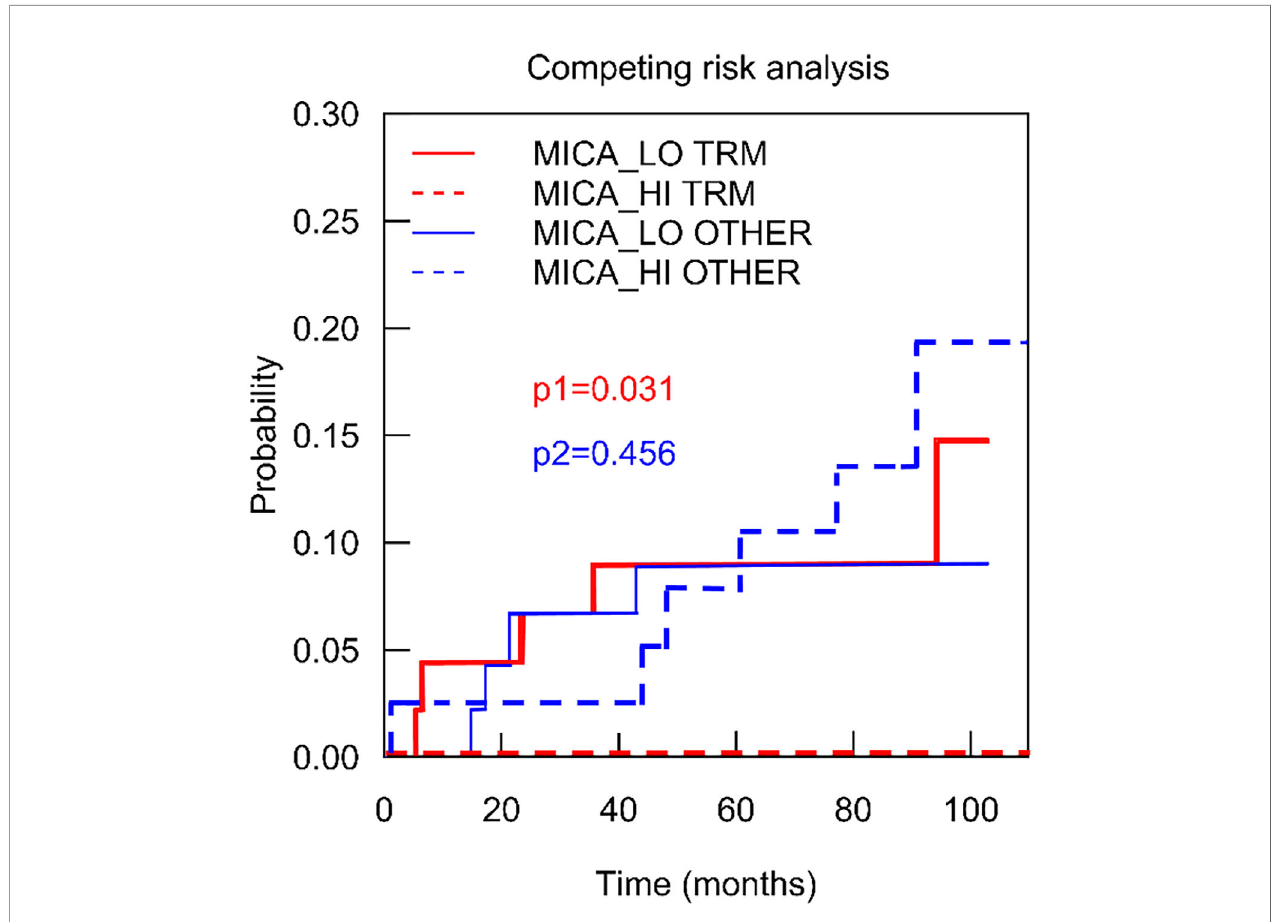
FIGURE 5 | Intragraft mRNA expression of MICA correlates transplant related mortality. To depict the association of MICA expression on mortality in detail, a competing risk analysis was calculated analyzing patients with transplant related mortality (red) and such patients with other causes of death (death with functioning graft) (blue). Low MICA expression (red line) was signi fi cantly associated with the occurrence of death in TRM patients (p = 0.031, Gray